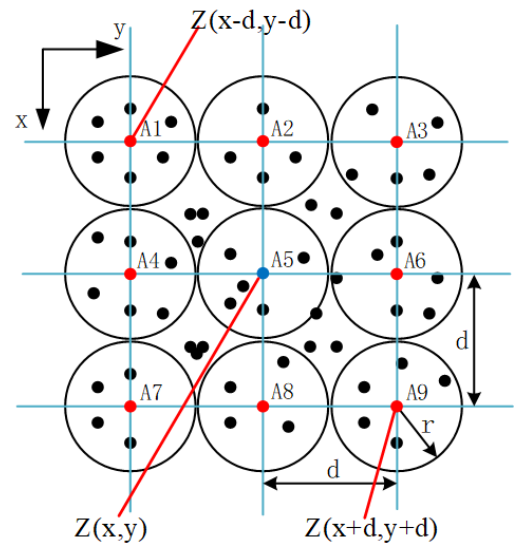
Figure 3. Sobel operator estimated by combining Gaussian kernel function.